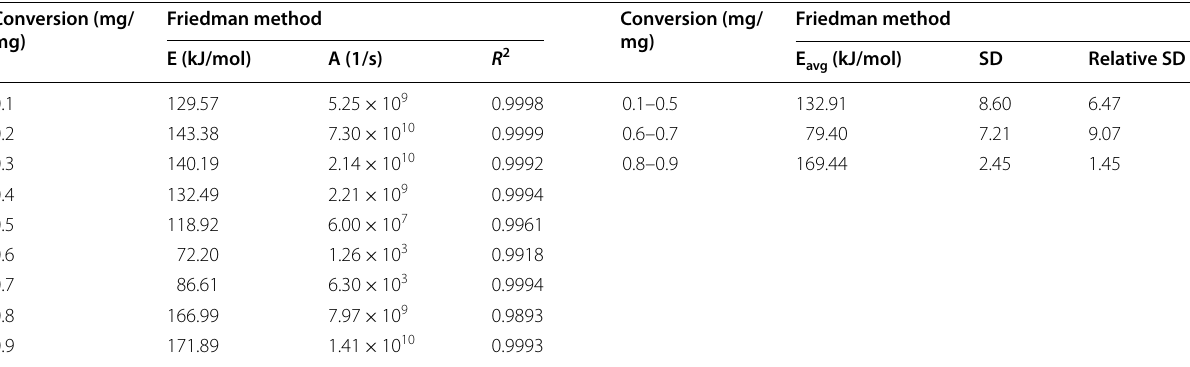
Table 4 Activation energies, pre-exponential factors, and correlation coefficients (R 2 ) for the entire combustion reaction using Friedman